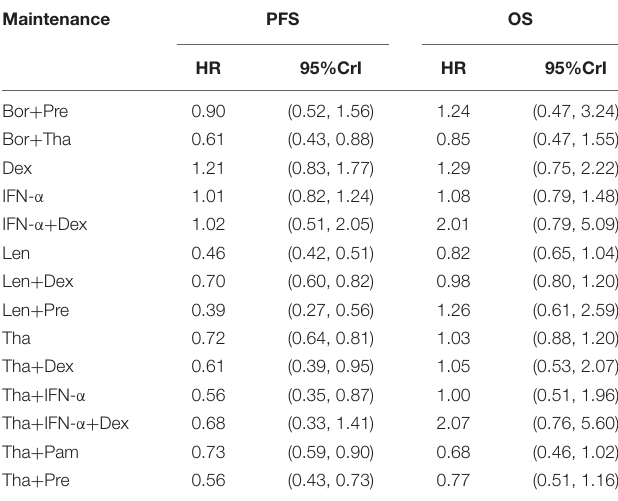
TABLE 2 | Network meta-analysis results, with observation/placebo as the common